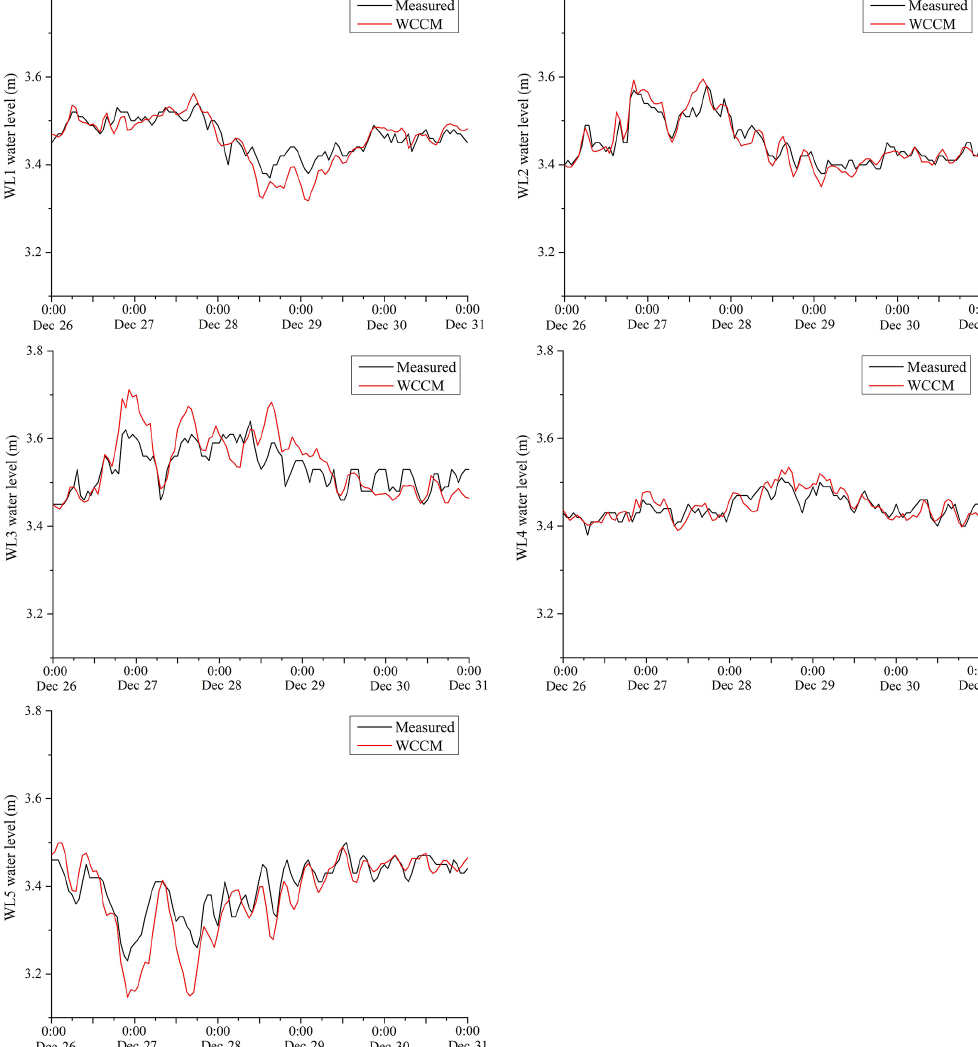
Figure 10. Comparison between the WCCM-simulated and measured water levels at the WL1–WL5 stations during the 2018 winter obser- vation. Table 4. Correlation coefficient (r) and root-mean-square error (RMSE) between the simulated and measured water level during the 2018 winter observation for the numerical experiments. Note that * indicates p< 0 . 05 and that ** indicates p< 0 .